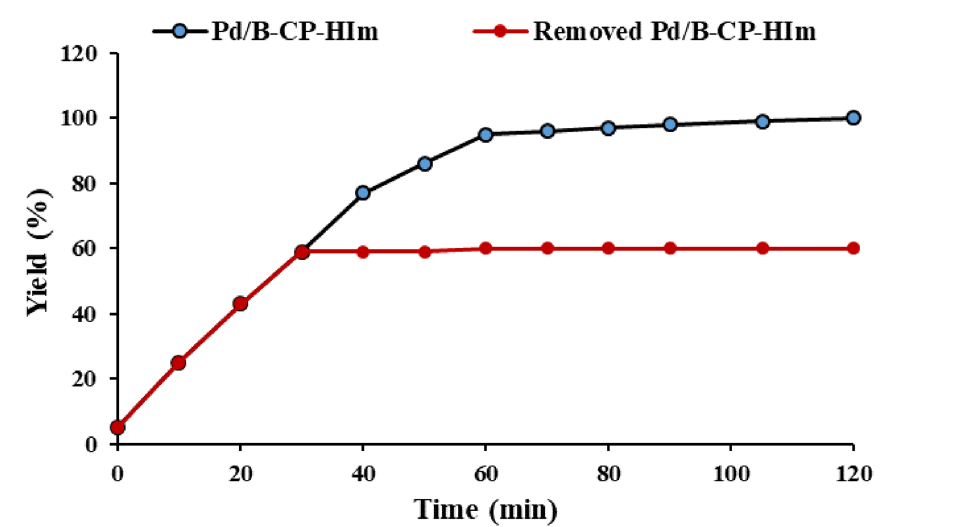
Figure 12. The result of hot filtration test for the model hydrogenation reaction under optimum reaction condition.